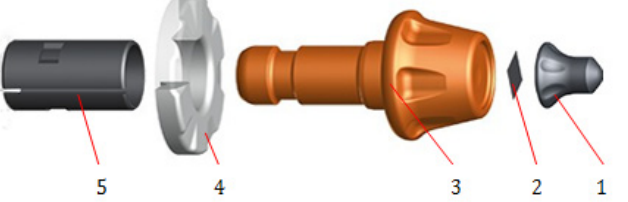
Figure 2. Components of a milling tooth: (1) tungsten carbide tip; (2) brazing tablet; (3) body; (4) wear plate; (5) clamping shank.